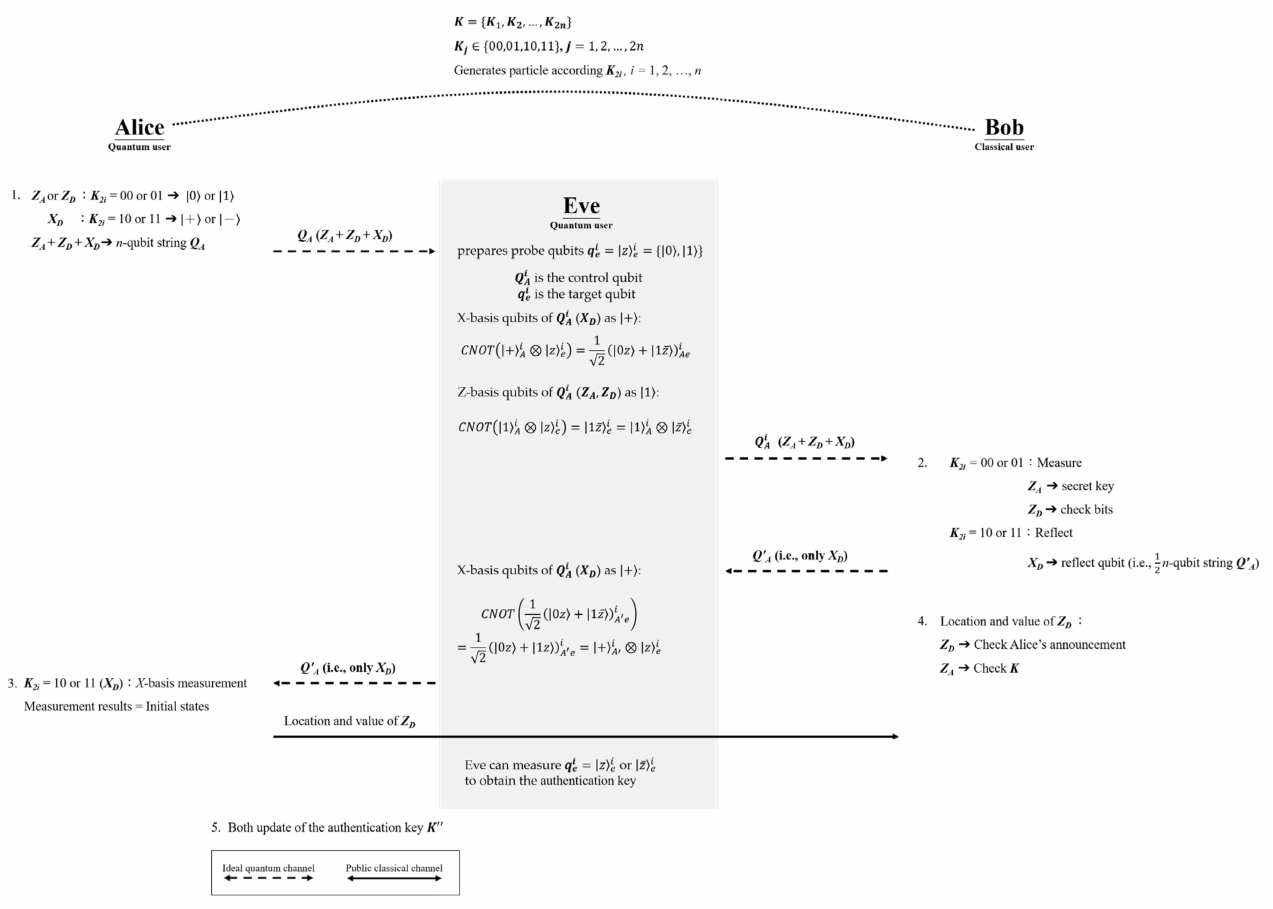
Figure 3. The double CNOT attack on Zhou et al.’s measure-resend SQA